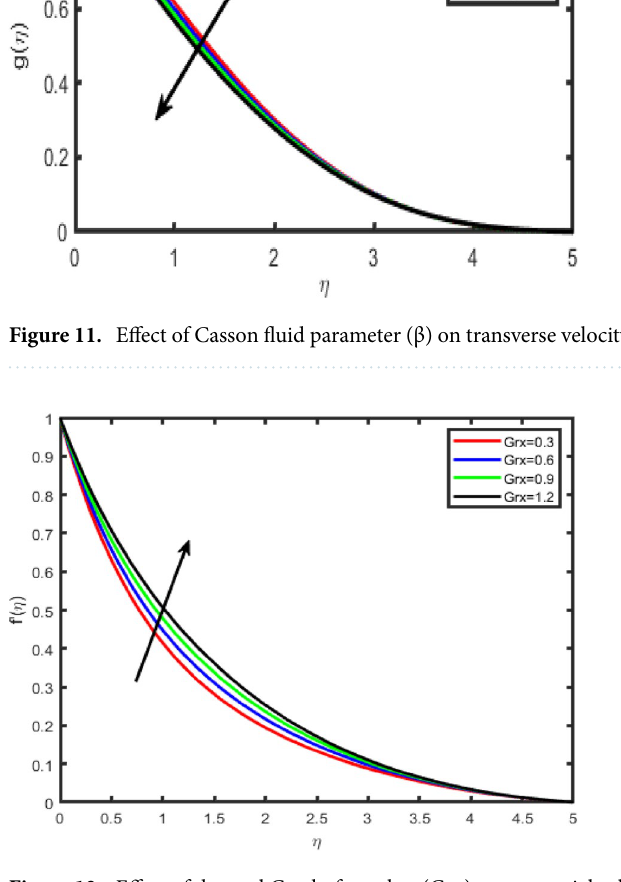
Figure 12. Effect of thermal Grashof number (Grx) on tangential velocity f ′